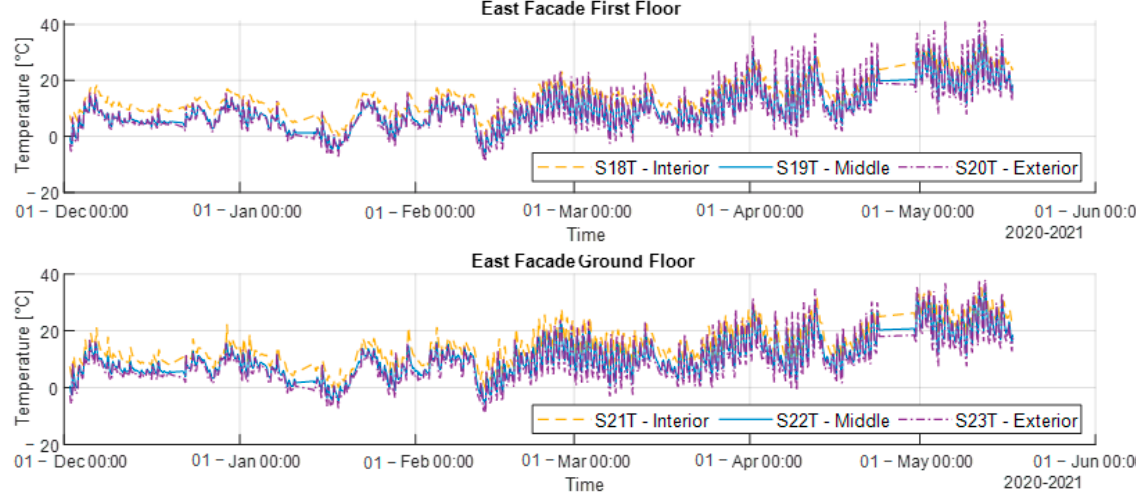
Figure 13. ( a ) Temperature data provided by the sensors for southern façade first floor.